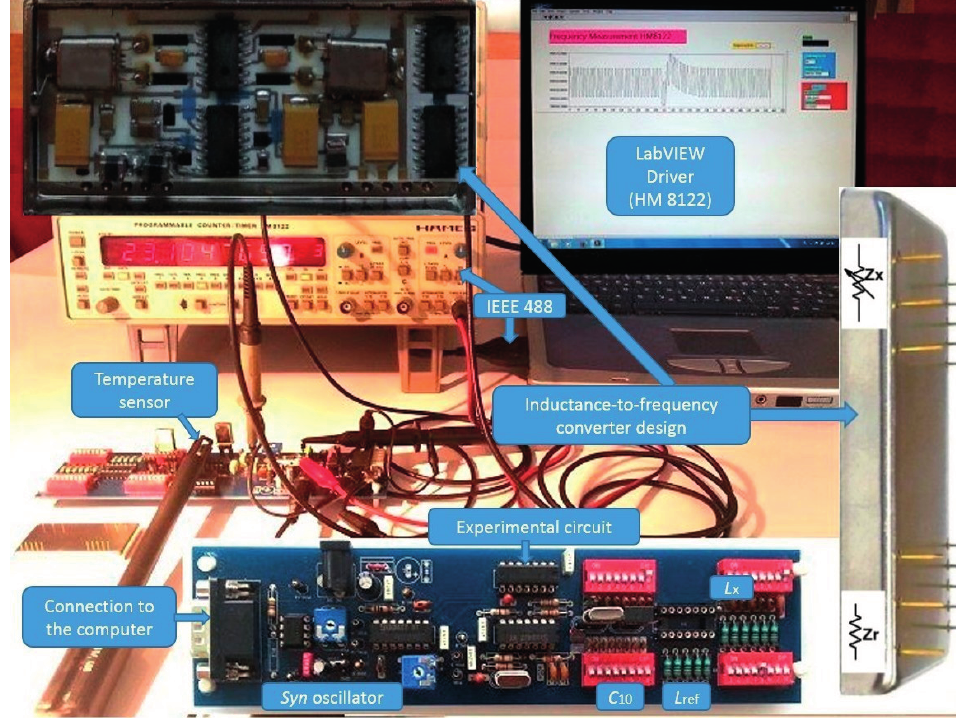
Figure 2. Experimental circuit and final inductance-to-frequency converter design with connection pins for industrial